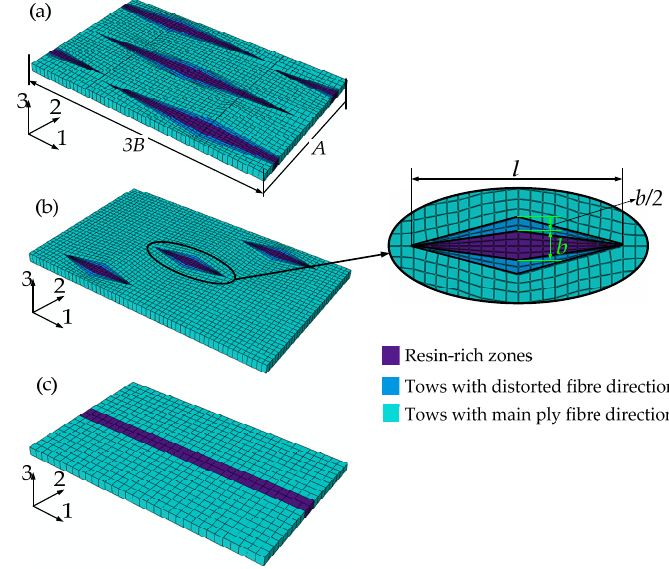
Figure 5. Finite element (FE) model of meso unit cells with different fiber distortion in the individual non-crimp fabric (NCF) lamina: ( a ) Cell A; ( b ) Cell B; and ( c ) Cell C.